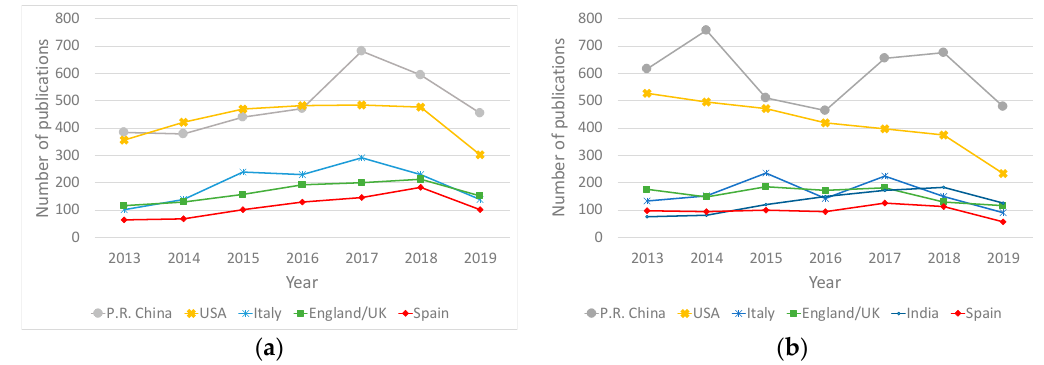
Figure 7. Trends in the number of publications in the area of study for the five countries with most publications: ( a ) Web of Science; ( b ) Scopus. Note that India ranks 10 in Web of Science, while Spain ranks 8 in Scopus.